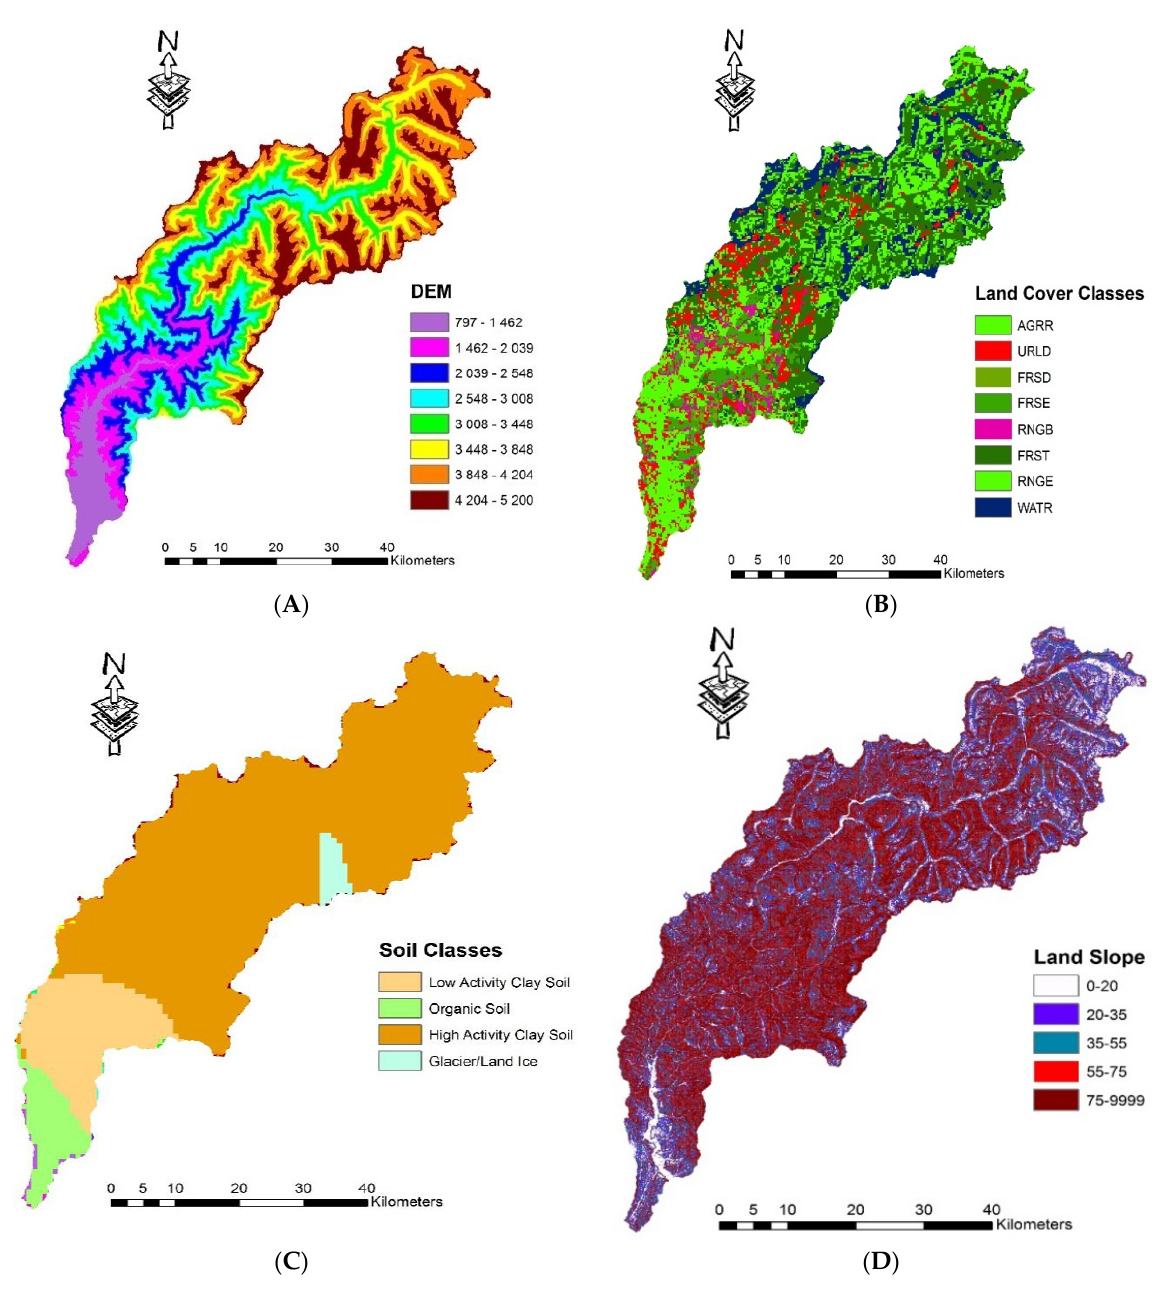
Figure 3. ( A ) DEM, ( B ) land use, ( C ) soil types, and ( D ) slope map of Kunhar basin. Intensive geospatial input data were required in order to extract the watershed HBV model. Topography, land use, soil, weather, and hydrological data were collected from dif- ferent sources/agencies (Table 2) and used in this model. Digital elevation models (DEMs), land-use/land-related maps, soil maps, environmental conditions, and hydrological details were the main inputs for the HBV model. A 30 × 30 m DEM (digital elevation model) from the USGS (National Elevation Dataset) dataset [55,56] is shown in Figure 3A; it was used to derive the drainage network of the watershed, sub-basins, and elevation maps for categorization. Land-use data at a spatial resolution of 300 m were obtained from the European Space Agency (ESA) database (Figure 3B). The land-use data consisted